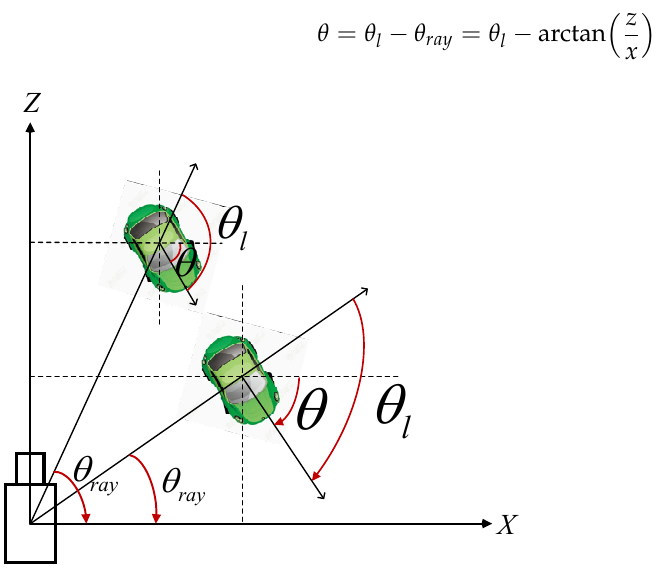
Figure 6. Difference between the global angle θ and the local angle θ l . θ ray is the angle between the ray from the center of the camera to the object and the X-axis of the camera, determining the imaging angle of the object on the image plane.